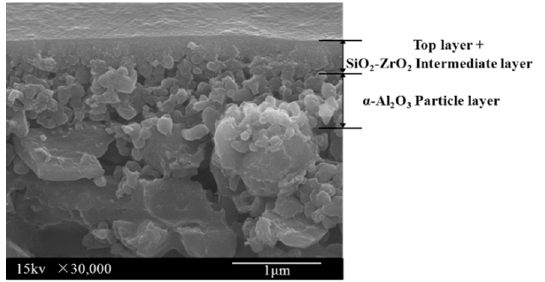
Figure3. Across-sectionalSEMimageontheconstructionsofBTESEmembranesincludingintermediate Figure 3. A cross-sectional SEM image on the constructions of BTESE membranes including and support layer. Reproduced from intermediate and support layer. Reproduced from [16] .